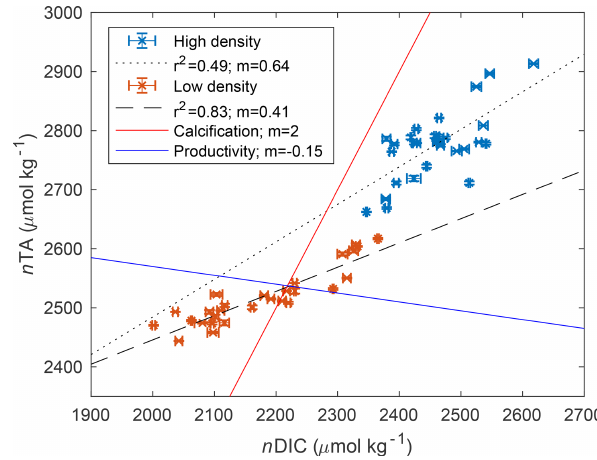
Figure 3. Scatter plot of n DIC and n TA for both high-density (blue) and low-density (orange) sites, and associated slope ( m ) and corre- lation coefficient ( R 2 ) of the linear regression. The red reference line indicates the expected relationship if calcification is dominant, consuming 2mol of TA for every mole of DIC consumed to form CaCO 3 . The blue reference line shows the approximate relationship expected for aerobic respiration and productivity, which consumes approximately 0.15mol of TA for every mole of DIC